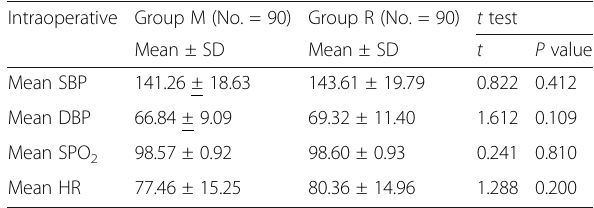
Table 2 Intraoperative haemodynamic parameters and O 2 saturation in both